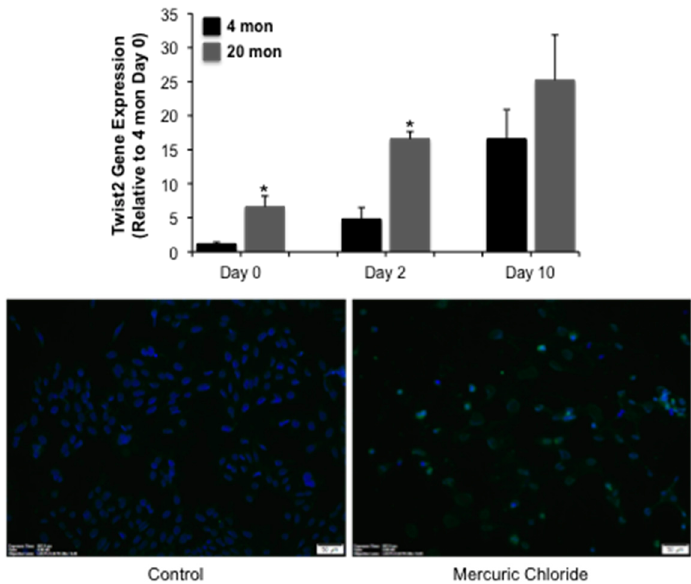
Figure 3. The impact of mercuric chloride on Twist2 expression. In the top panel, 20 mon old rats were challenged with mercuric chloride and Twist2 expression was assessed 2 or 10 day after injury. Each data point represents the mean + SEM of 3–4 animals, * indicates a significant difference from young control (4 mon). In the bottom panel, DCT209 cells were challenged with 5 µM mercuric chloride for 24 h and Twist2 expression assessed by immunofluorescence (green staining), scale bar = 50 µm; similar results were seen in two replicate experiments.